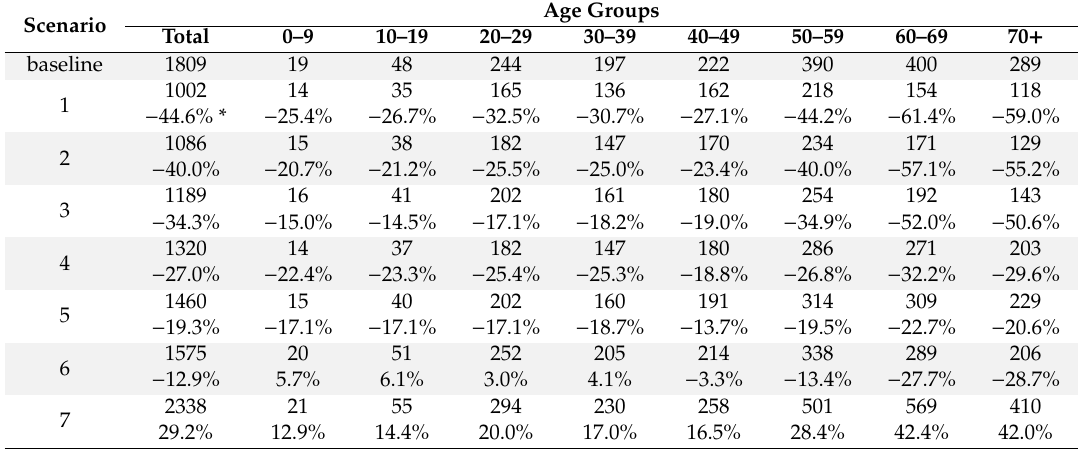
Table 7. Cumulative incidence for each age group from 1 February to 31 August 2020.